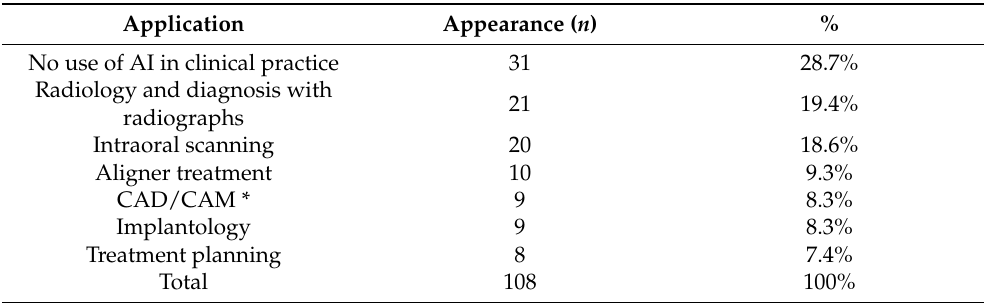
Table 1. Applications of artificial intelligence (AI) mentioned in an open-ended